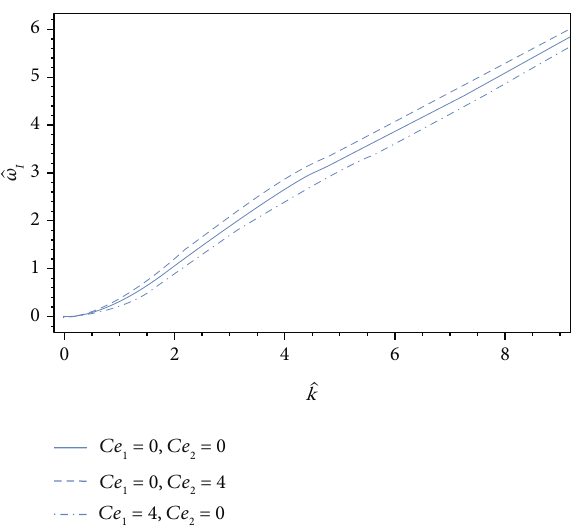
Figure 8: E ff ect of magnetic fi eld on growth rate at b ρ = 0 : 002 , b μ ′ = 0 : 5 , b μ = 0 : 03 , L = 0 : 3 , b β = 0 : 3 , b ε Oh = 100 .